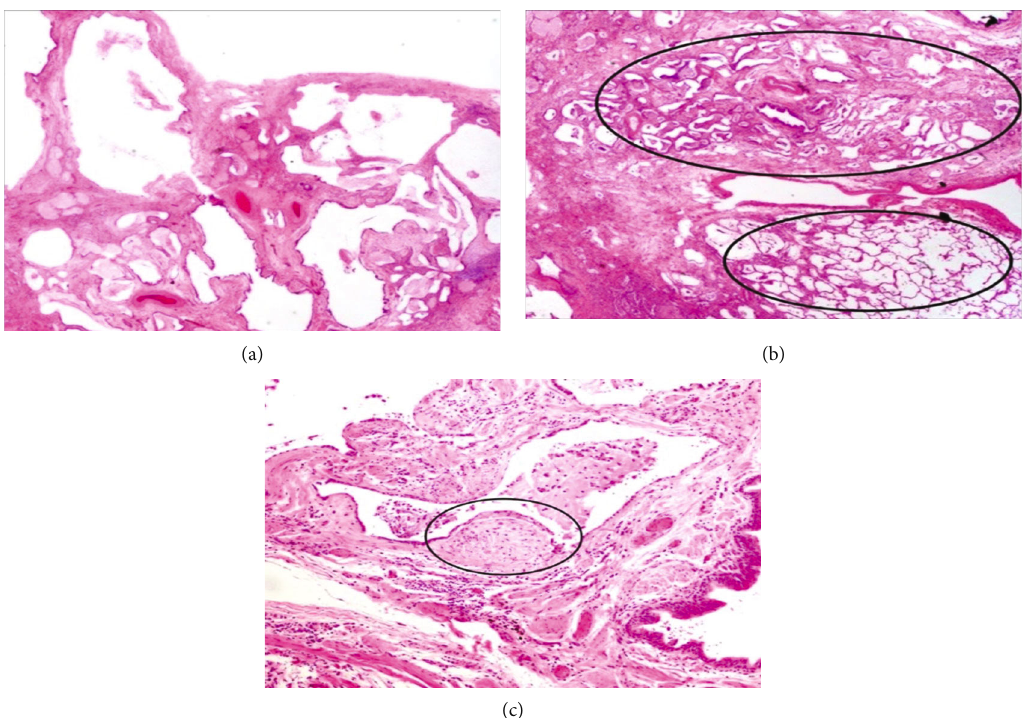
Figure 2: (a) Histopathology specimens demonstrating extensive areas of established fi brosis and extensive remodelling producing honeycombing. (b) Histopathology section demonstrating subpleural and paraseptal predominance of the fi brosis with small areas of relative preservation without fi brosis. (c) Histopathology section demonstrating the presence of fi broblast foci.